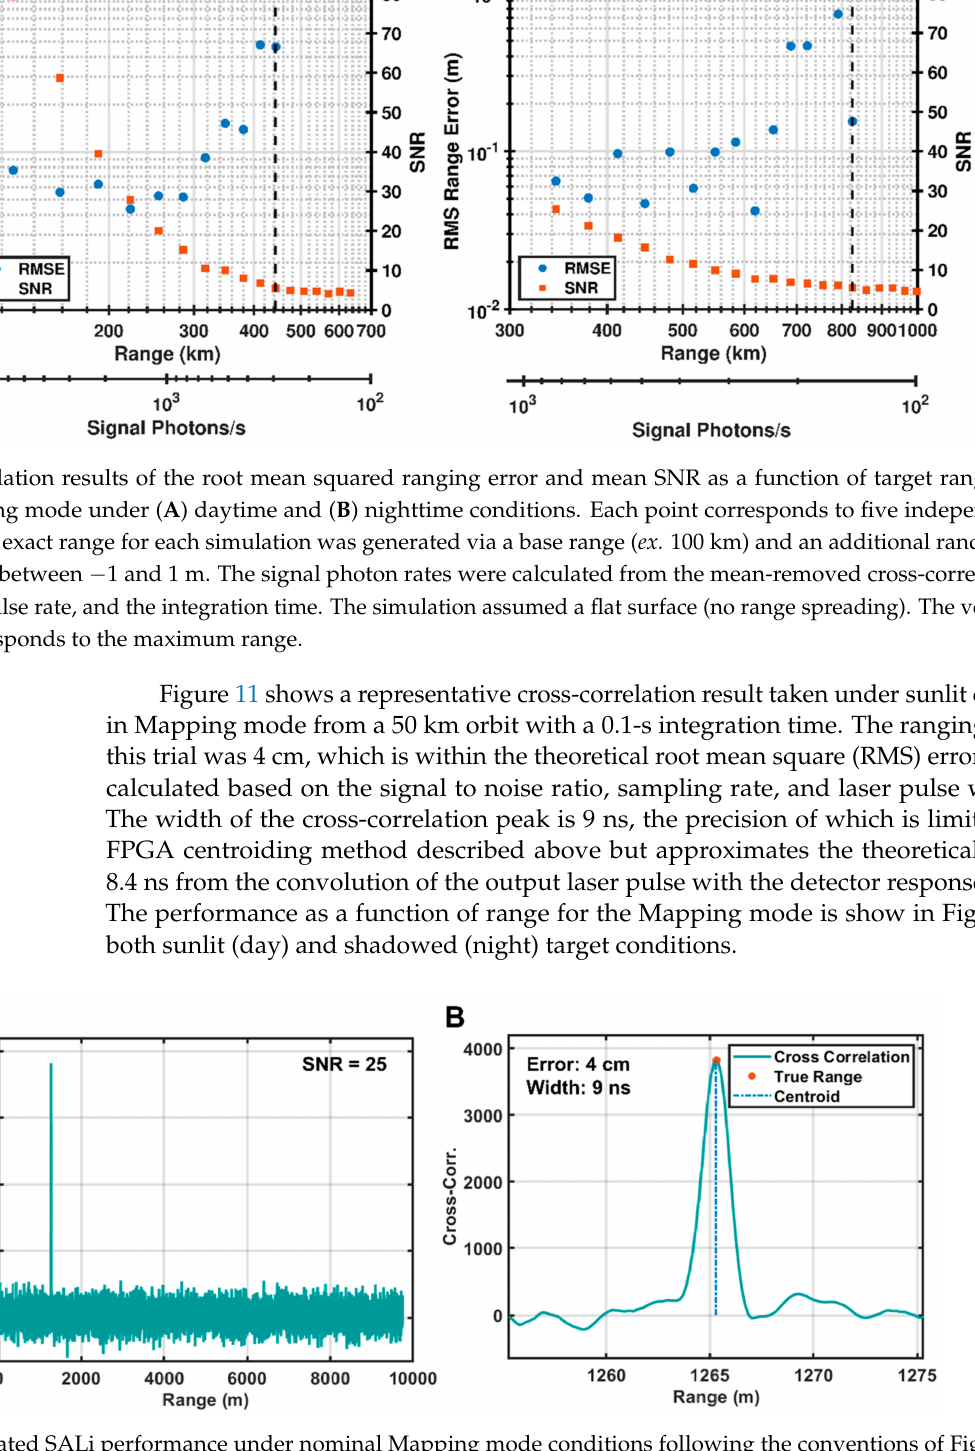
Figure 11. Simulated SALi performance under nominal Mapping mode conditions following the conventions of Figure 9. ( A ) Full cross-correlation results. ( B ) Cross-correlation region near the cross-correlation peak. The simulation assumed a flat surface (no range